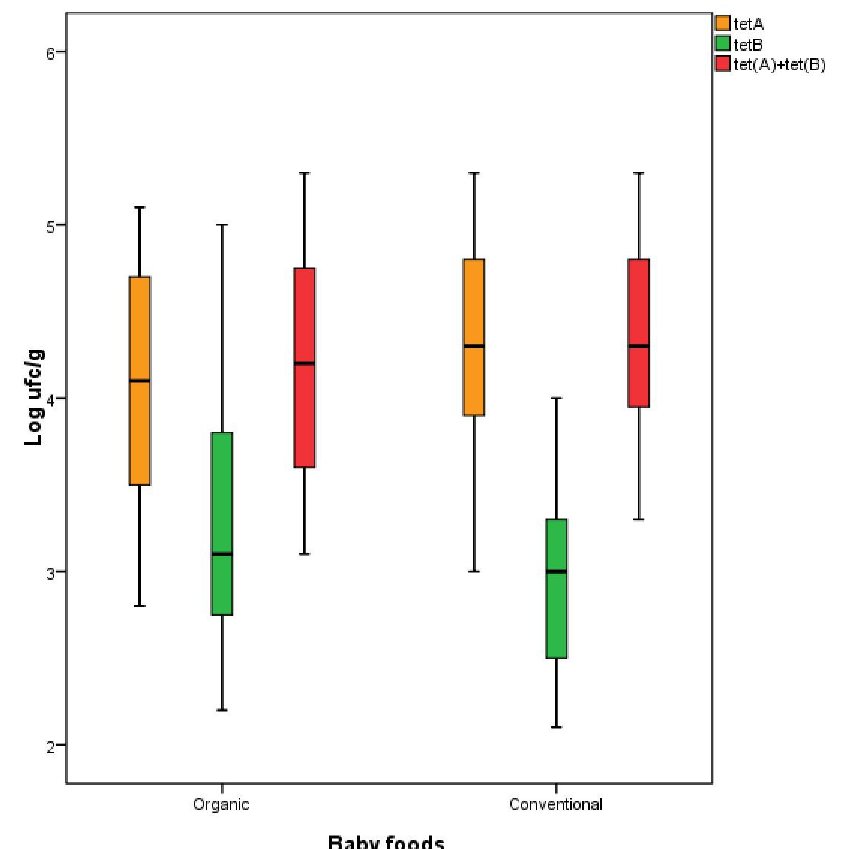
Figure 1. Box plots showing a comparison of the counts of bacteria harboring the tet (A) and/or tet (B) genes between organic and conventional baby foods. Notes: The box limits are in the 25th and 75th percentile, and the band in the middle of the box is the median; the whiskers are in the 1.5 interquartile